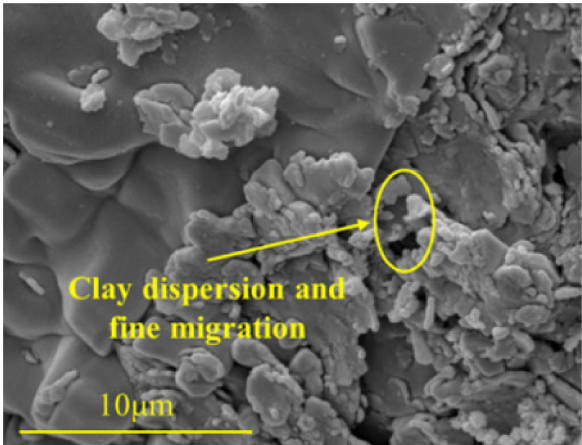
Figure 9. Clay dispersion and fine migration after rock–fluid interaction